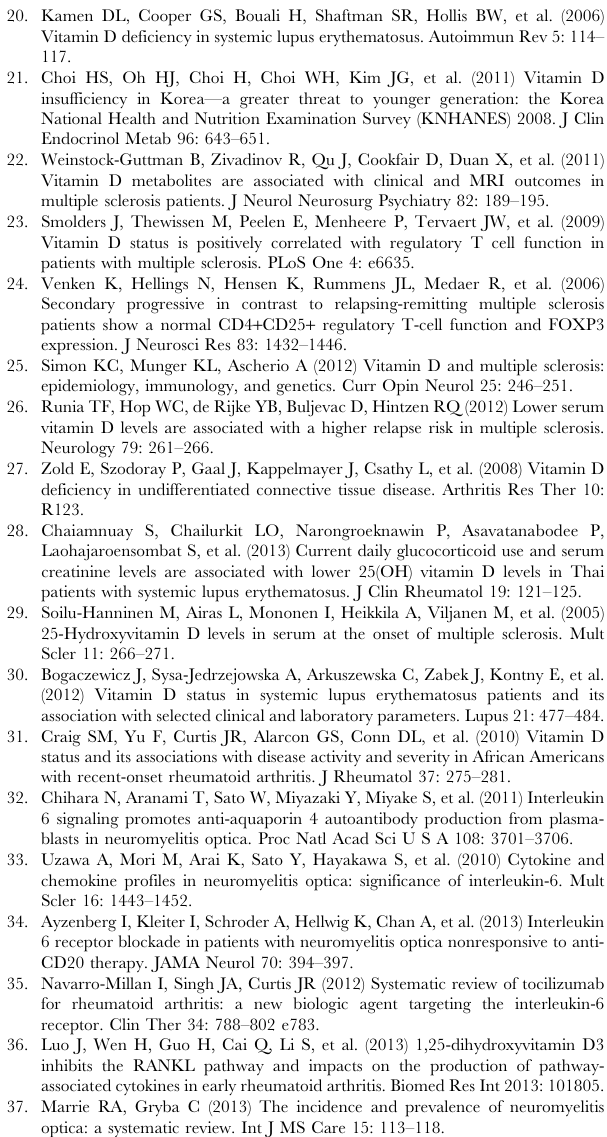
Table S2 Spearman’s correlation analysis for the relationship between 25-hydroxyvitamin D 3 (25(OH)D 3 ) levels and annualized relapse rate (ARR) in patients with NMOSD. Table S3 Generalized estimating equation model for the relationship